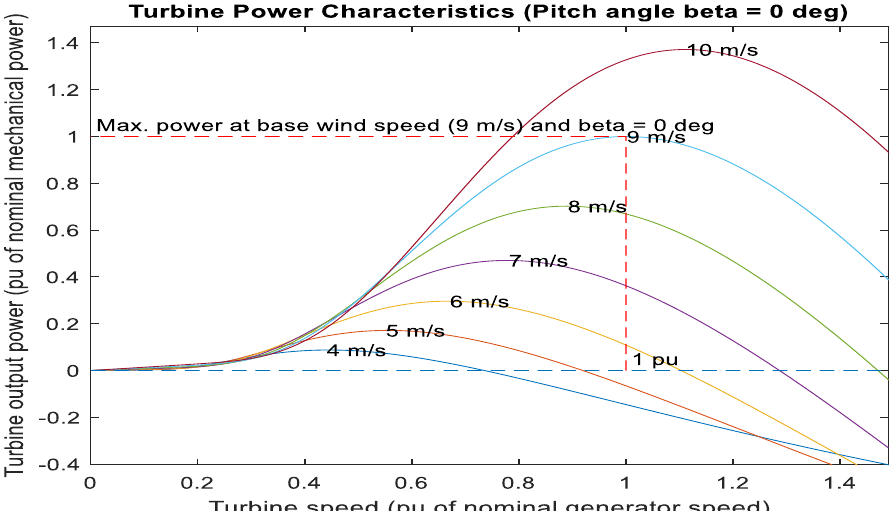
Figure 8. SCIG wind turbine power Figure 8 . SCIG wind turbine power curve.